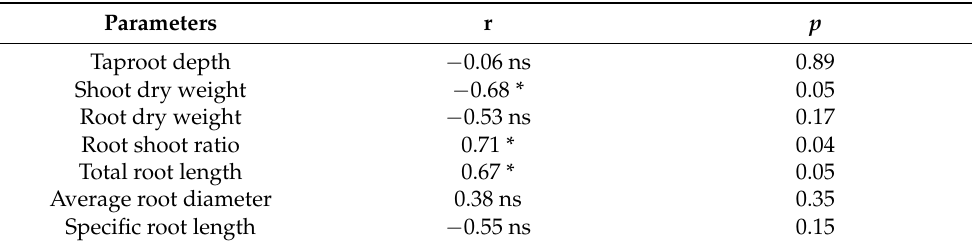
Table 4. Correlation (r) and probability values ( p ) of seven parameters selected in the same eight soybean genotypes grown in a semi-hydroponic system (experiment 1) and soil-filled rhizoboxes (experiment